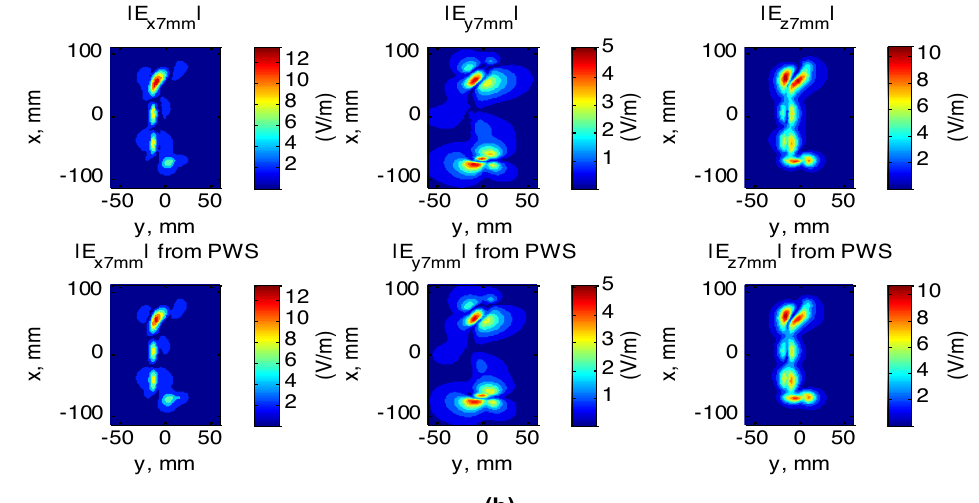
Figure 8: Comparisons of the E-field maps computed directly from the analytical defintion and from the PWS method proposed at (a) z = 5 mm and (b) z = 7 mm.